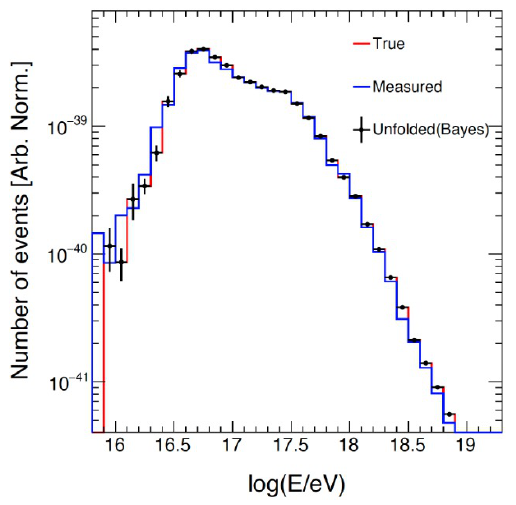
Figure 3. True, measured, and unfolded energy spectra. The unfolded spectrum is obtained through the unsmearing process of the measured spectrum based on the unsmearing matrix. The unsmearing is successfully performed and the unfolded spectrum is consistent with the true